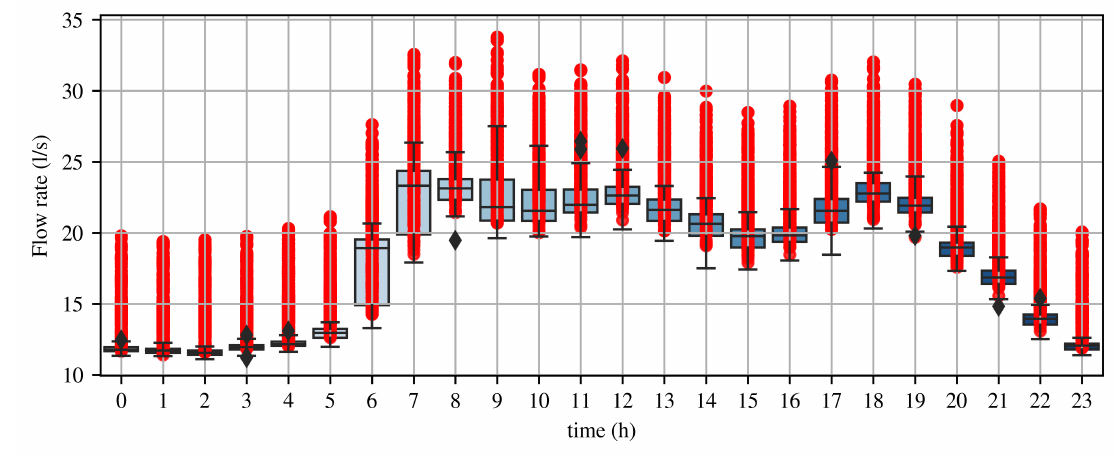
Figure 11. Box & Whiskers plot for each hour of the day of the 10 generated samples of April consumption of the Egna